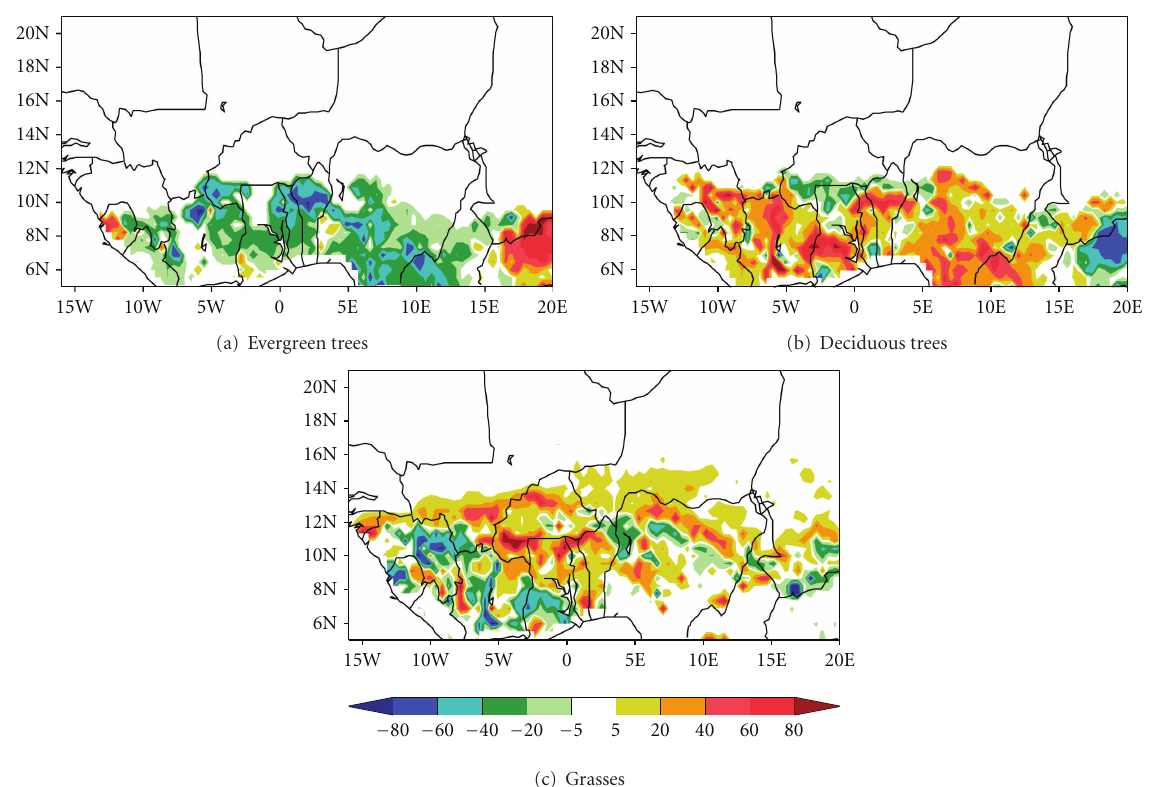
Figure 2: Changes in fractional coverage of vegetation types (“Future”—“Present”) as percent of vegetated portion of grid cell.